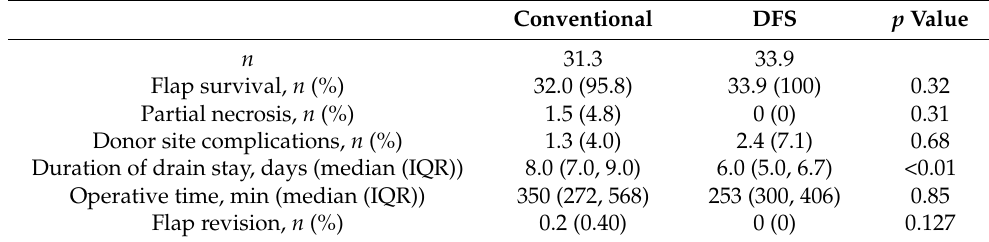
Table 2. Surgical results after IPW.